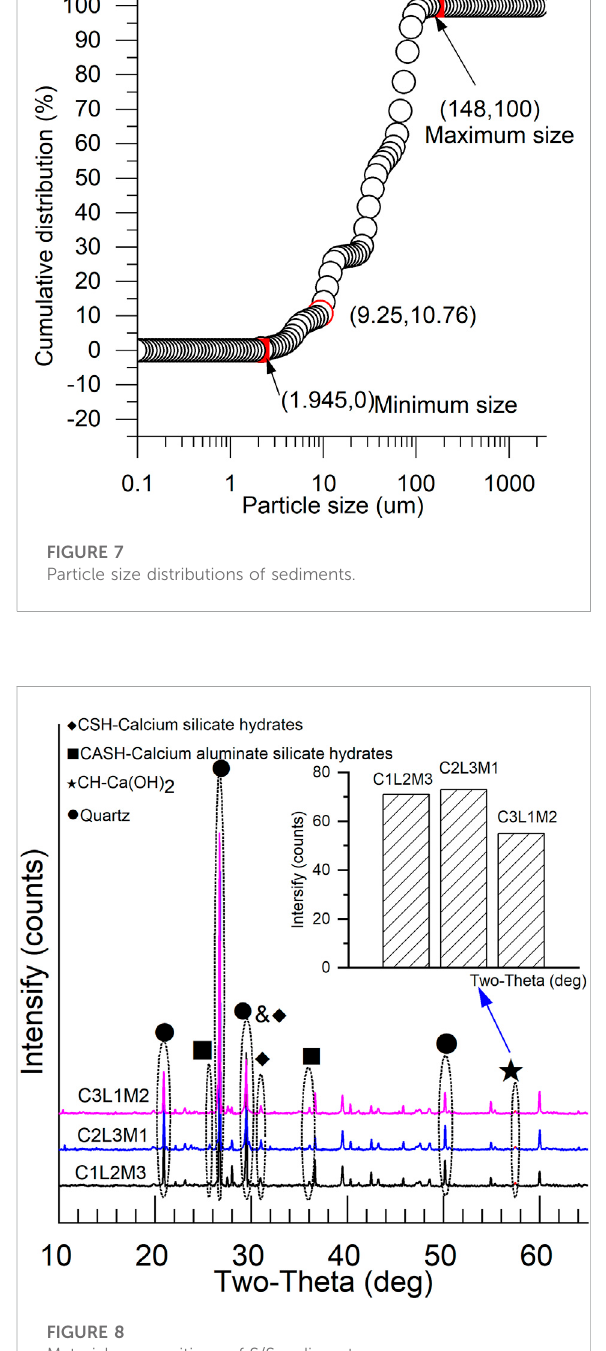
FIGURE 8 Material compositions of S/S